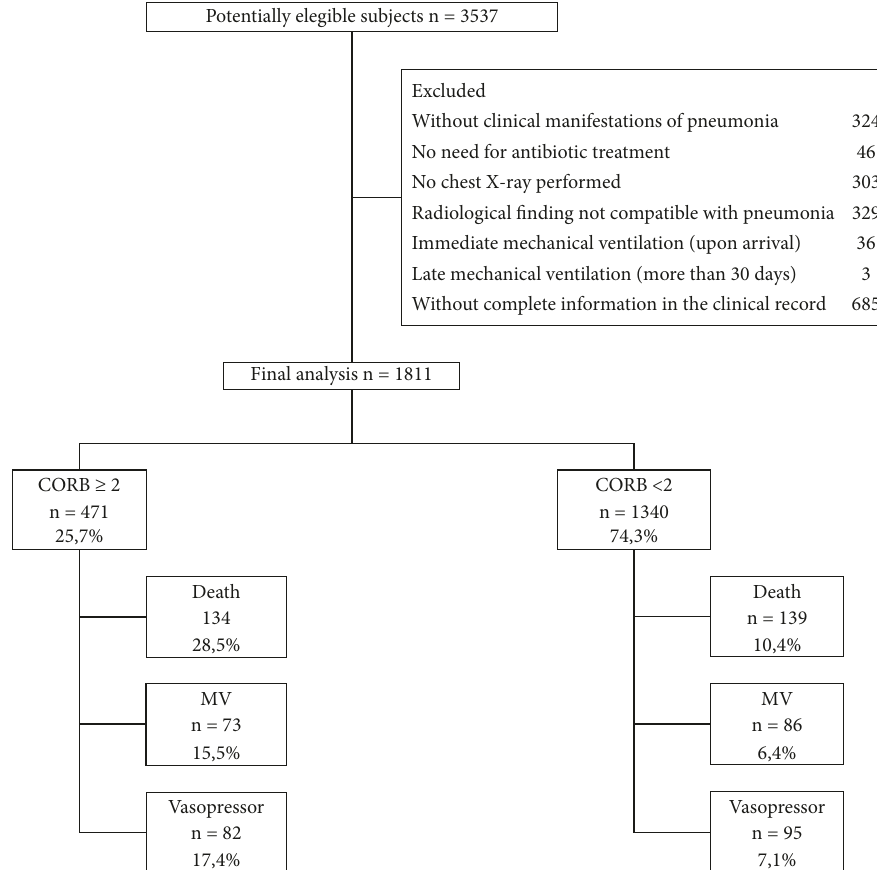
Figure 1: Flowchart of study subjects’ entry. FiO2: fraction of inspired oxygen. CORB: confusion (new onset or deterioration of preexisting condition), oxygen